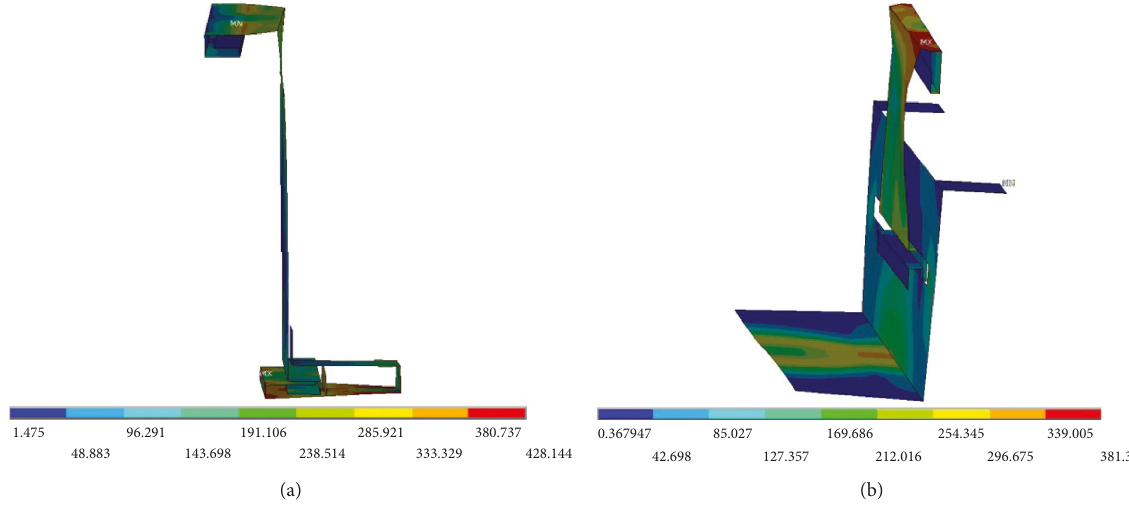
Figure 7: Deformation and stress distribution of sliding clips: (a) LS003 clip and (b) S3PC-1 clip.